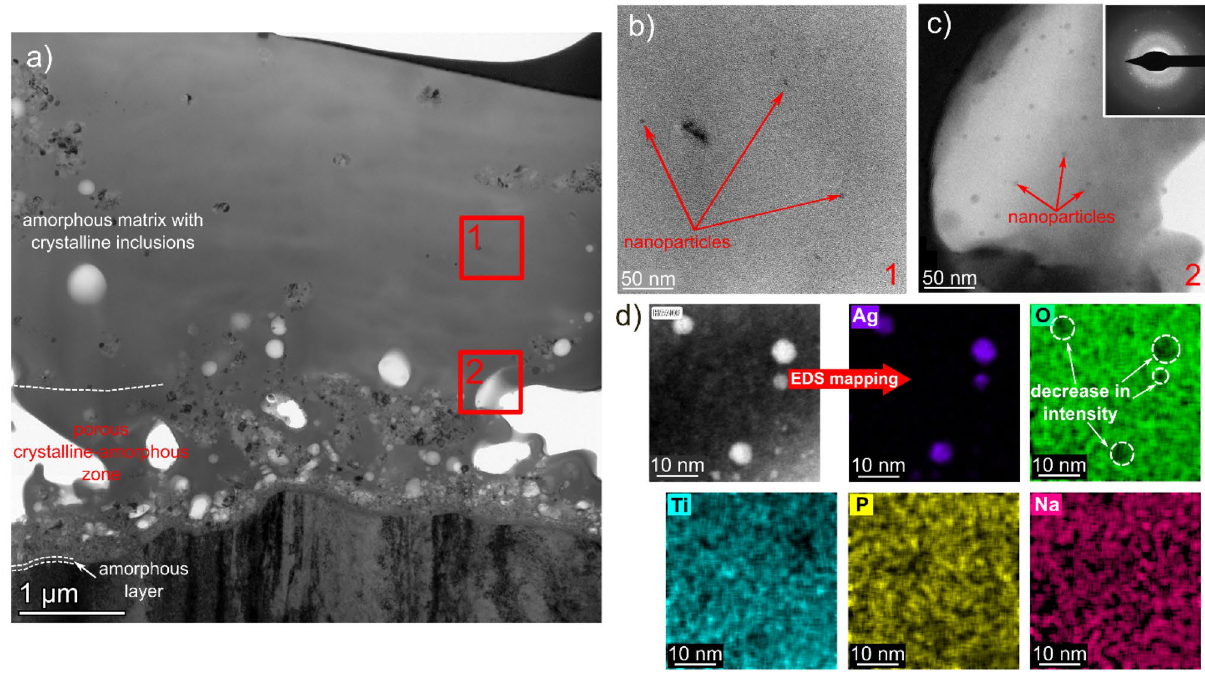
Figure 2. TEM/STEM images of MAO coating with Ag addition: BF images presenting a general overview of the coating ( a ), Ag-NPs in the central part of the coating ( b ), and agglomerates near the pores ( c ) as well as STEM/HAADF image showing Ag-NPs and accompanying EDS maps presenting distribution of Ag, O, Ti, P, and Na distribution ( d ).